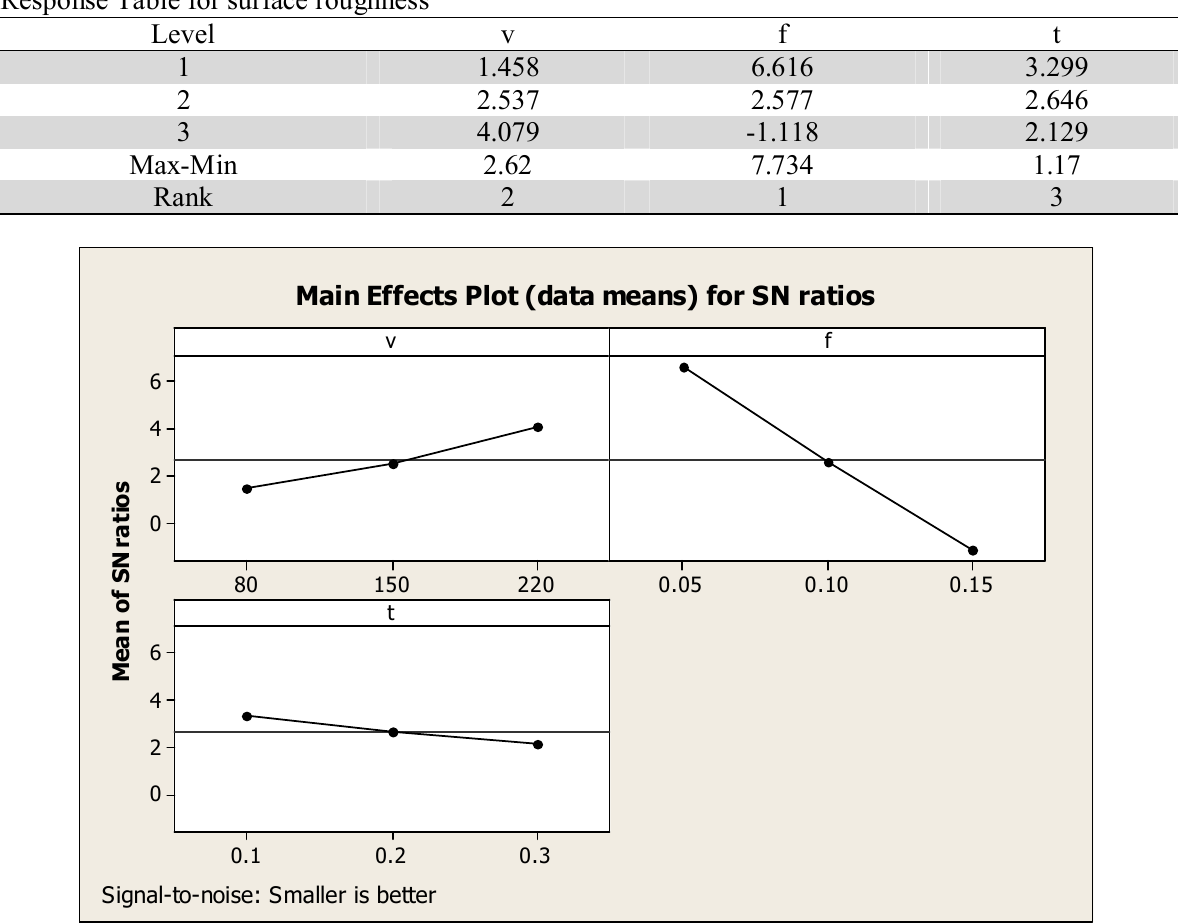
Fig. 7. Mean S/N ratios for surface